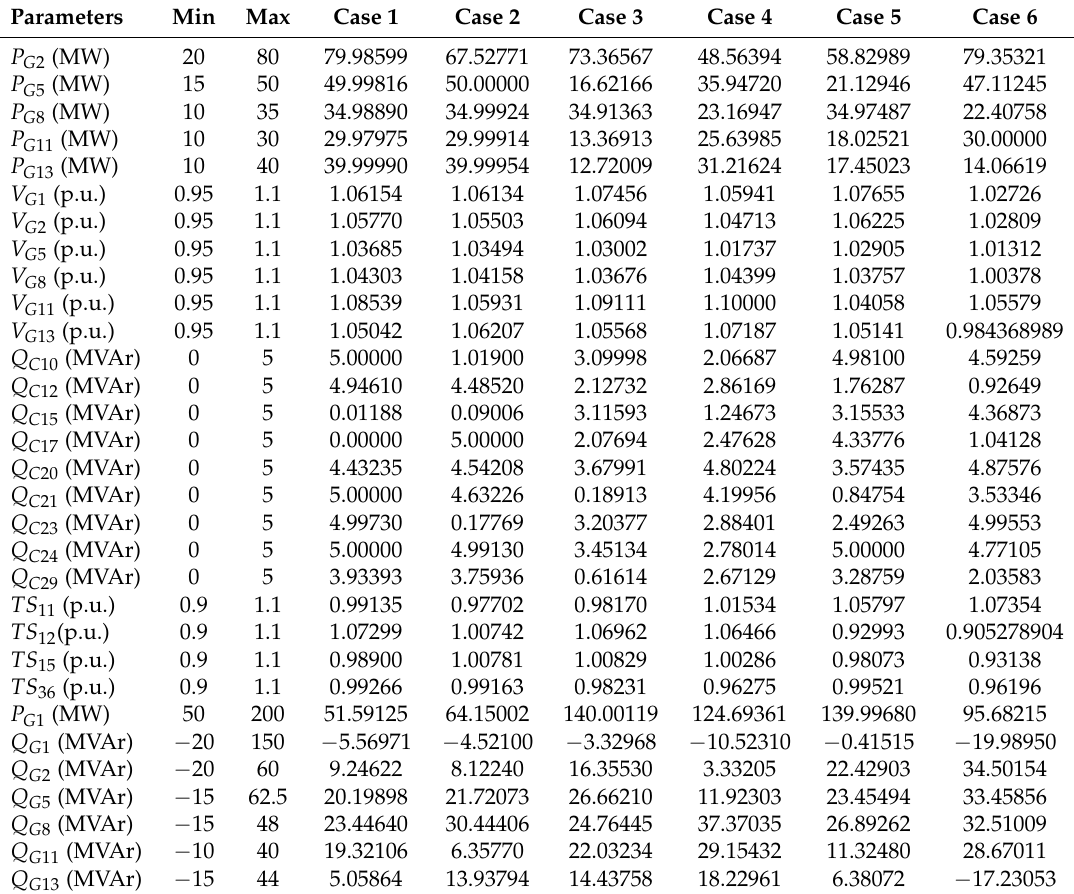
Table A7. Optimal solution obtained by GROM for single-objective OPF for IEEE 30-bus system. Parameters